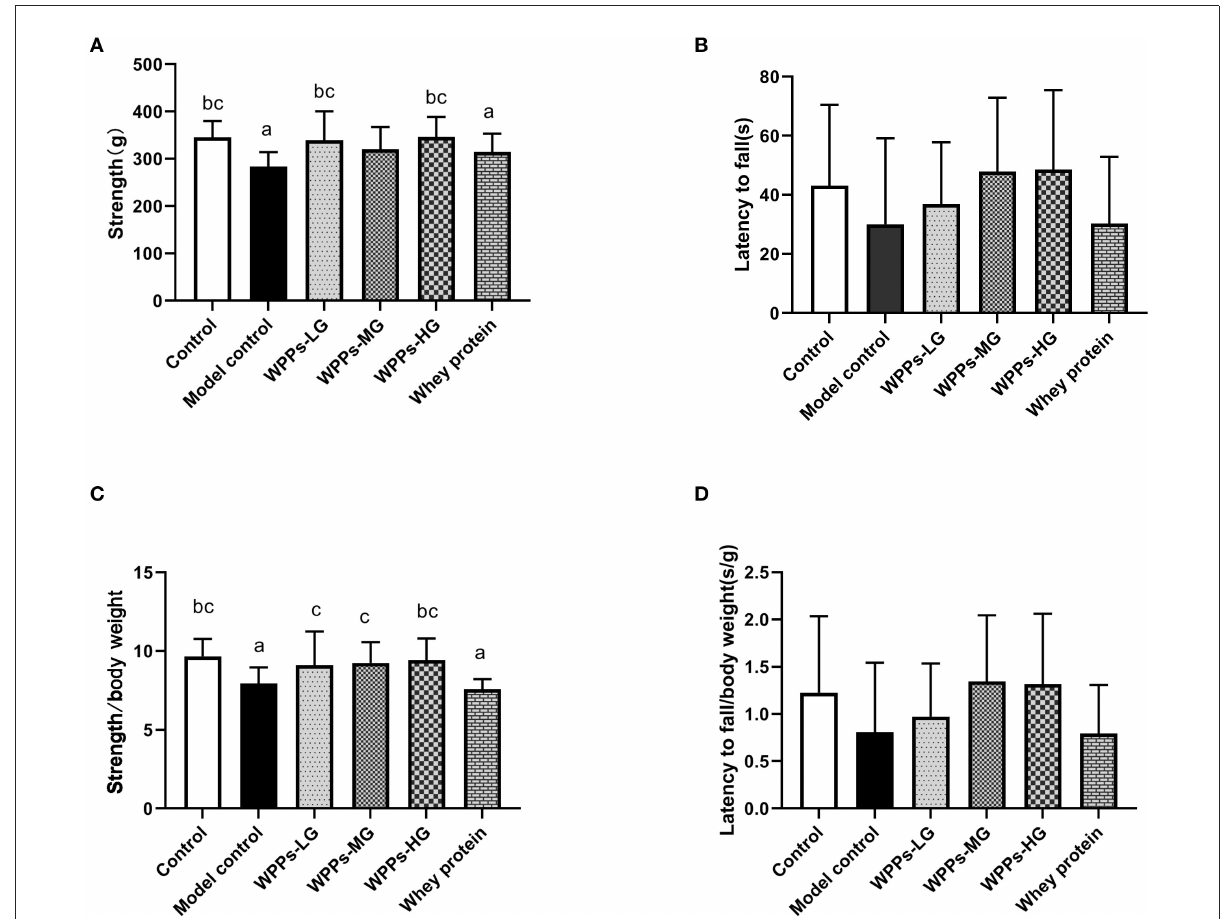
FIGURE3 Effects of WPPs on the grip strength (A) , suspension force (B) , grip strength/body weight (C) , suspension force/body weight (D) . Data are expressed as means ± SD ( n = 8). a p < 0.05 indicates significant difference vs. the control group; b p < 0.05 indicates significant difference vs. the model group. c p < 0.05 indicates significant difference vs. the whey protein group. Whey protein group at a dose of 1.5 g/kg; WPPs-LG, whey protein peptides low-dose group at a dose of 0.3 g/kg; WPPs-MG, whey protein peptides medium-dose group at a dose of 1.5 g/kg; WPPs-HG, whey protein peptides high-dose group at a dose of 3.0